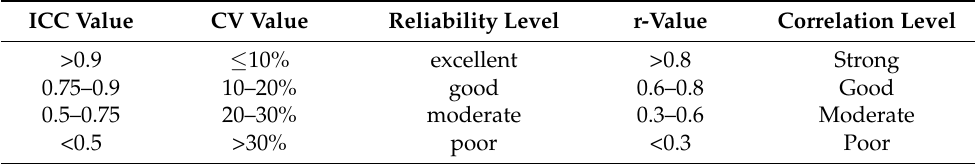
Table 3. Criteria for interpreting ICC, r, and CV